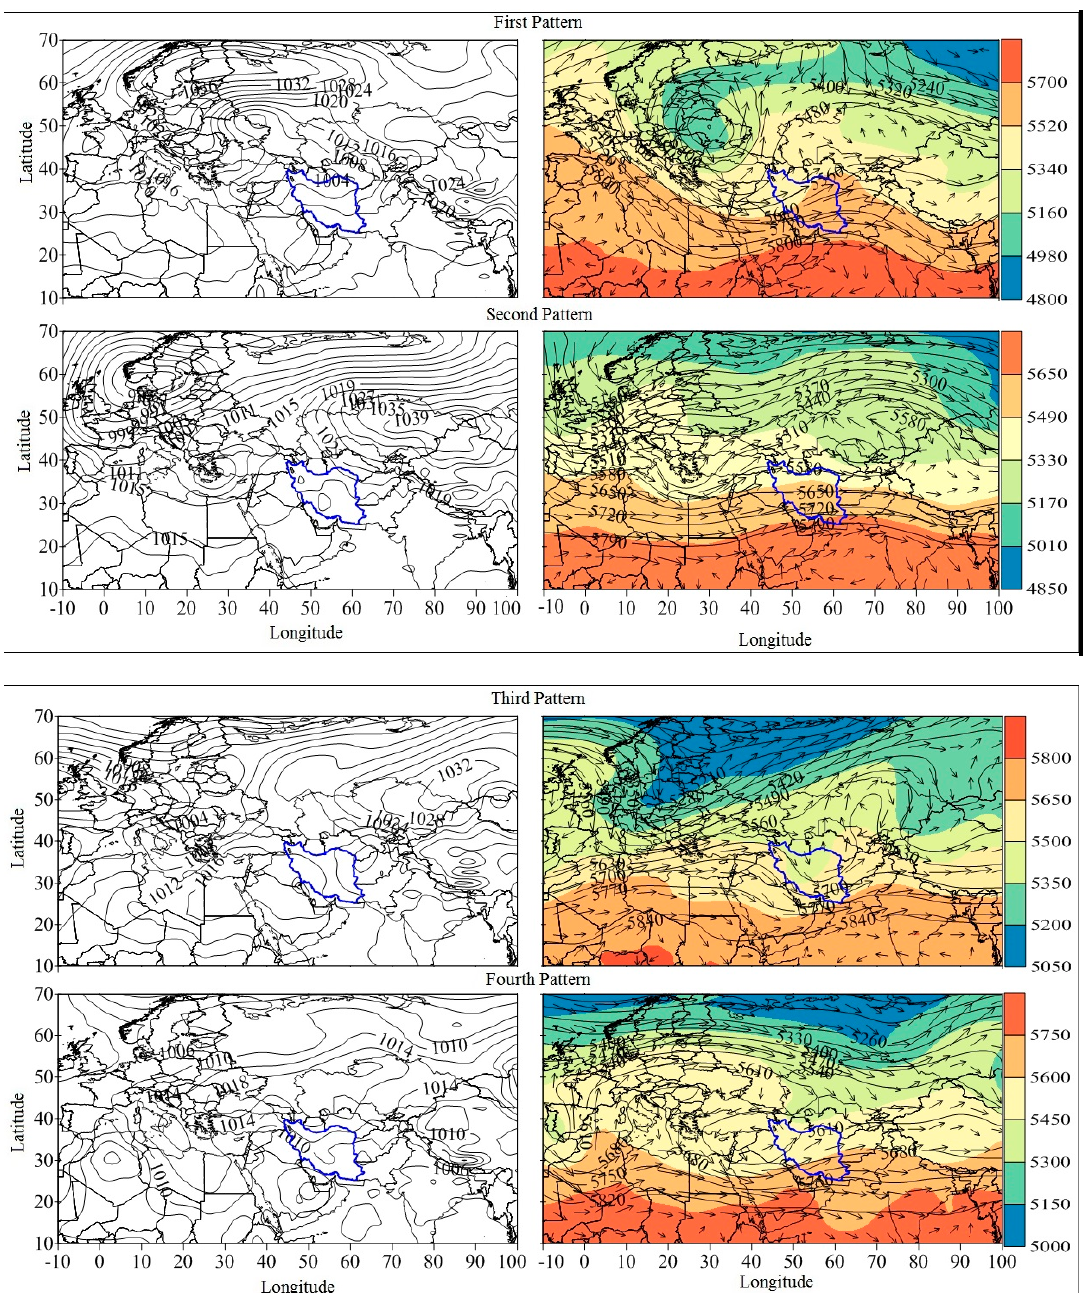
Figure 5. The thickness patterns of the Iran’s comprehensive precipitation.